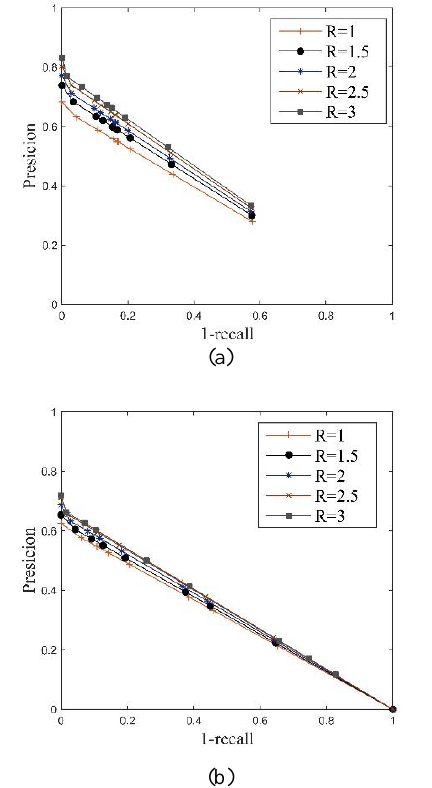
Figure 9. PR (precision-recall) curves of quantitative analysis in different supervoxel resolutions on two MLS road data. (a) Road1, (b)